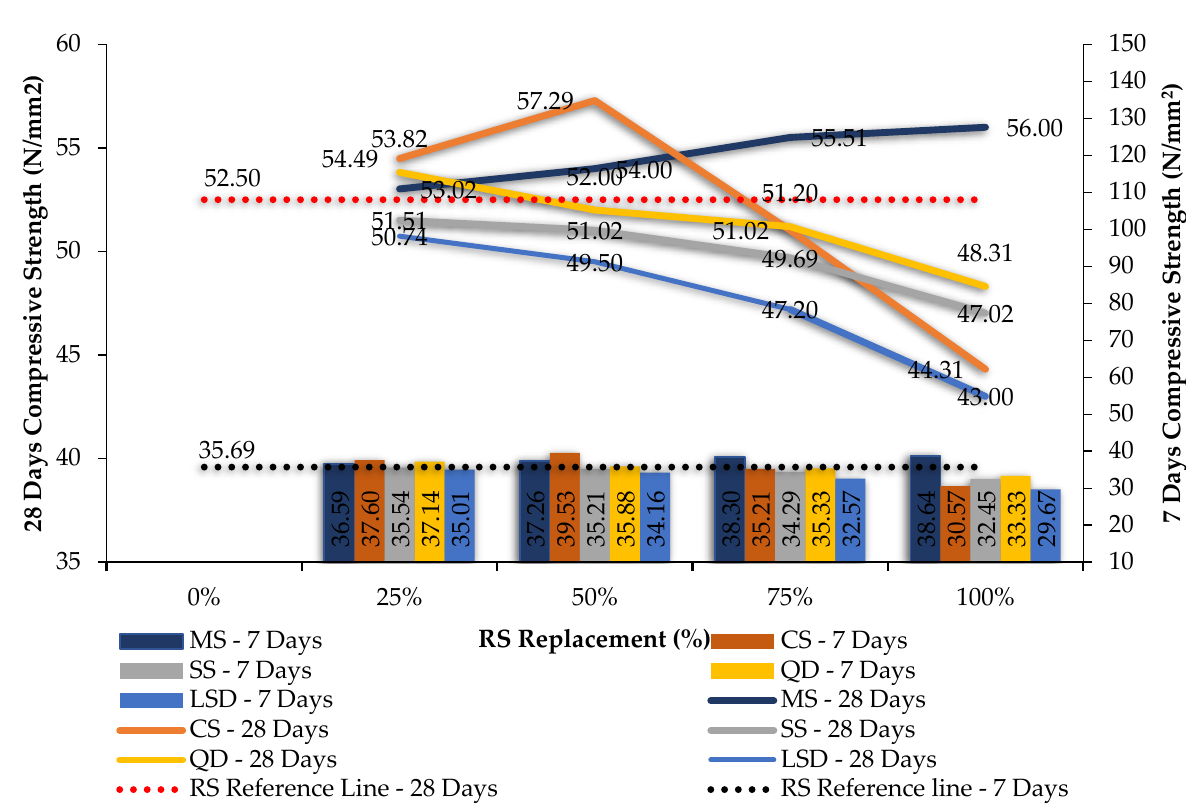
Figure 5. The 7- and 28-day compression test results for M 40 GPC with various fine aggregates.